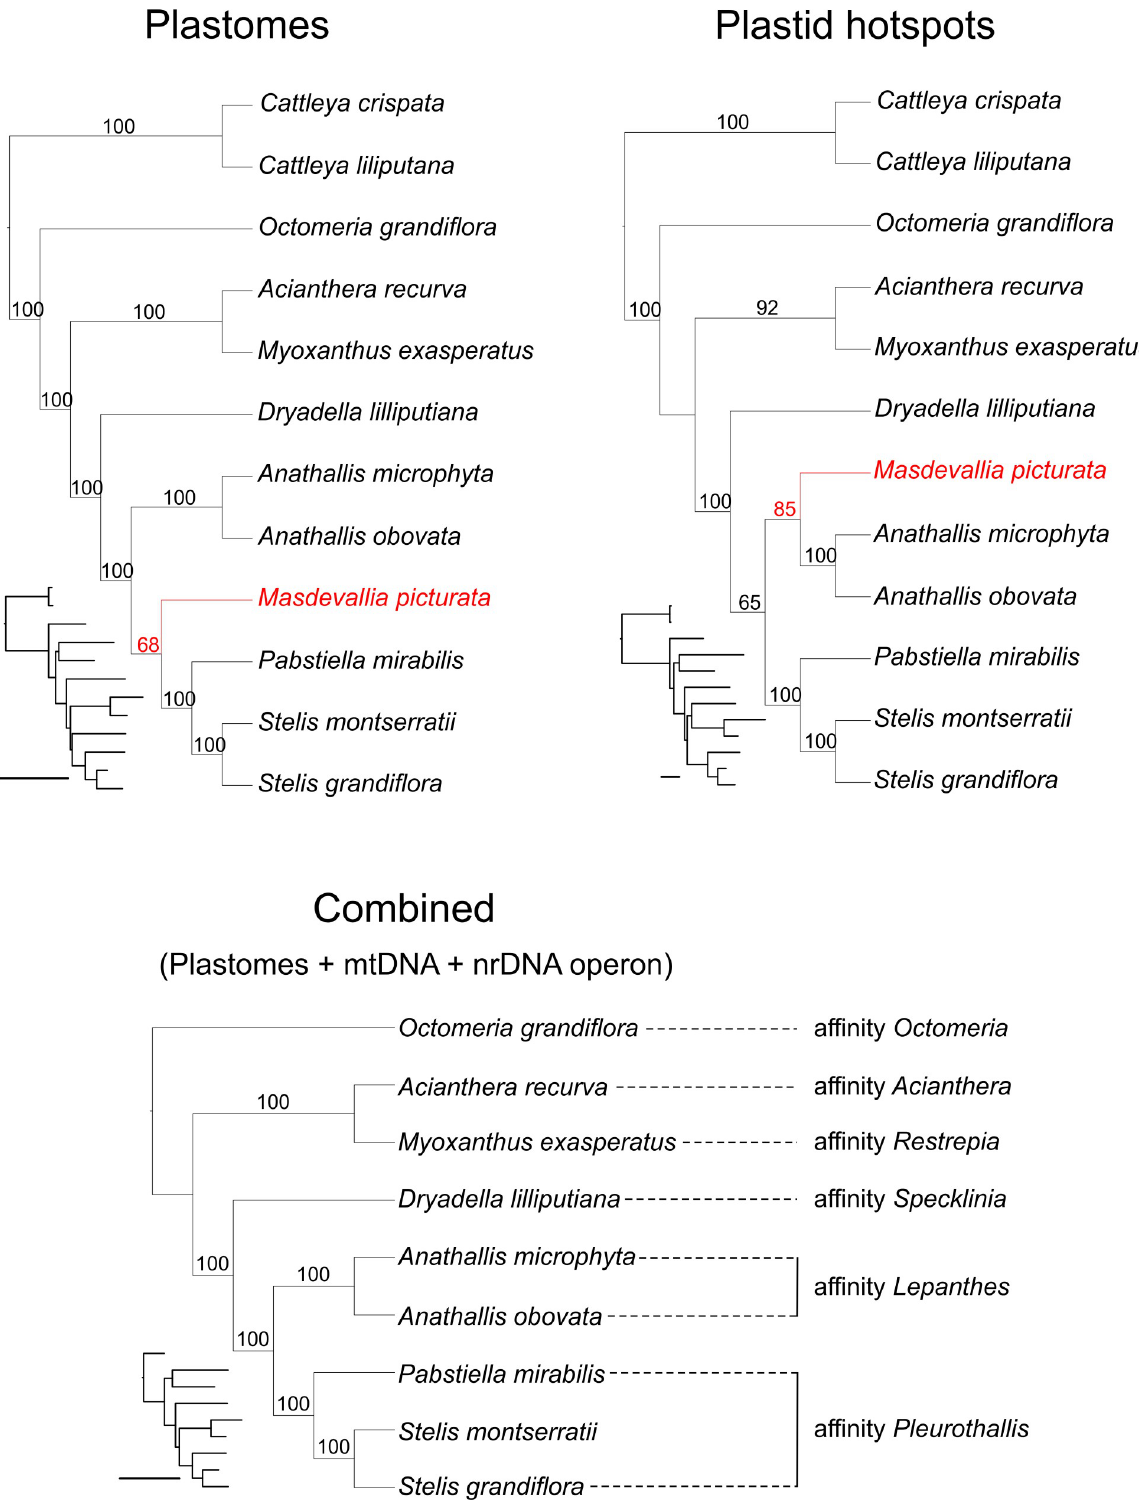
Fig 4. Maximum likelihood trees based on complete plastomes (one IR), plastid hotspots, and combined analyses (plastomes (one IR) + mtDNA + nrDNA operon). Numbers on branches are the bootstrap percentages; a tree with proportional branch lengths is on the left of each tree, which bars represent 0.02 nucleotide substitutions per